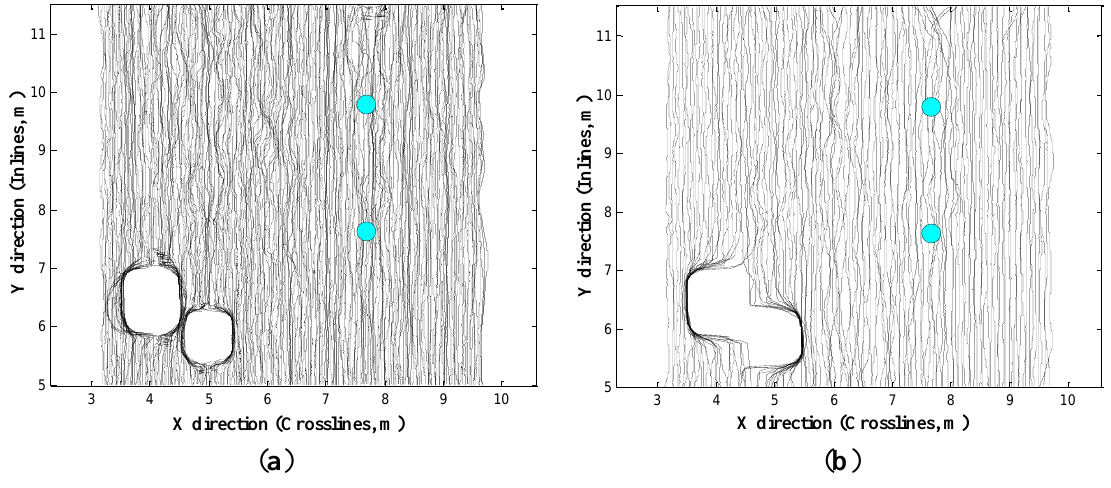
Figure 2. Moving trajectories of antennas recorded by the 3D GPR system, and blue circles show the locations of the tree stumps. ( a ) 800 MHz shielded antenna; ( b ) 500 MHz shielded